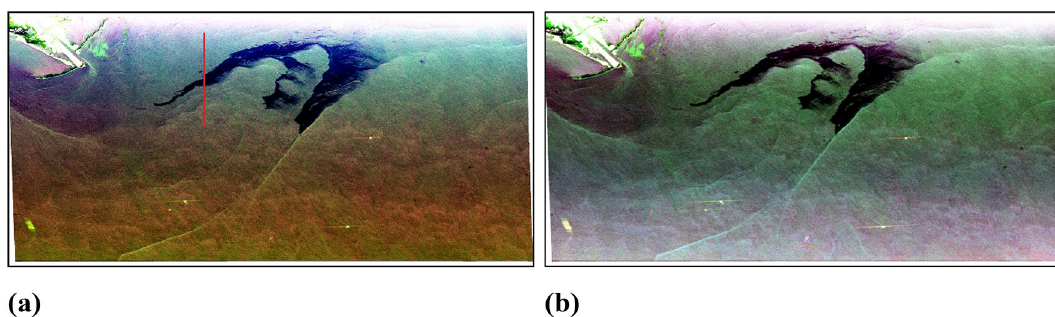
Figure 4. Figures showing Pauli RGB composite of data ( a ) before incidence angle correction, and ( b ) after incidence angle correction at reference angle θ ref =